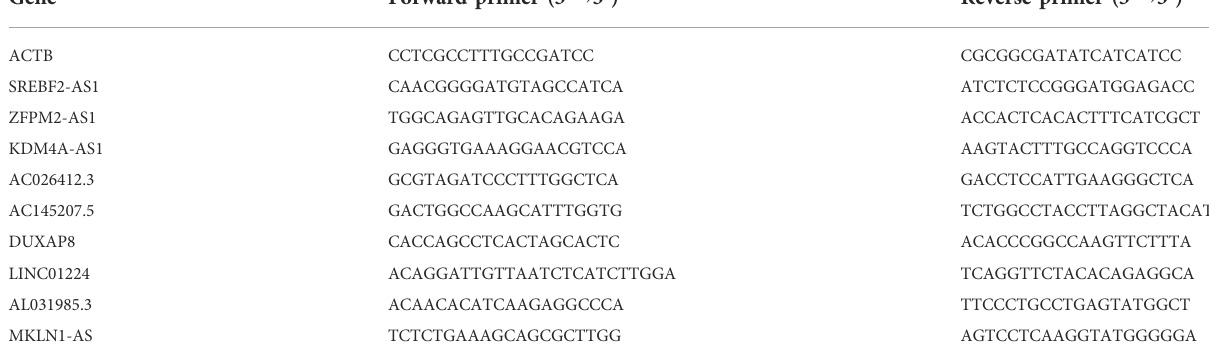
TABLE 4 LncRNAs constituting a prognostic